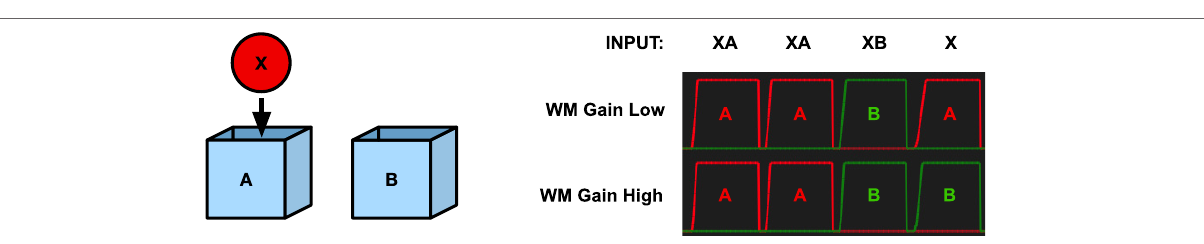
FigUre 6 | Simulation of the A-not-B task. Left—The object X and the two boxes A and B. Right—The graphs show the activation of the place code with low or high working memory gain for place A (red) and B (green), respectively, as response to different inputs. X represents the object stimulus, and A and B represent the two boxes. The final input X corresponds to the questions “Where is X?” With an undeveloped prefrontal cortex (low working memory gain) the model replies A. With a developed prefrontal cortex (high working memory gain), the model replies